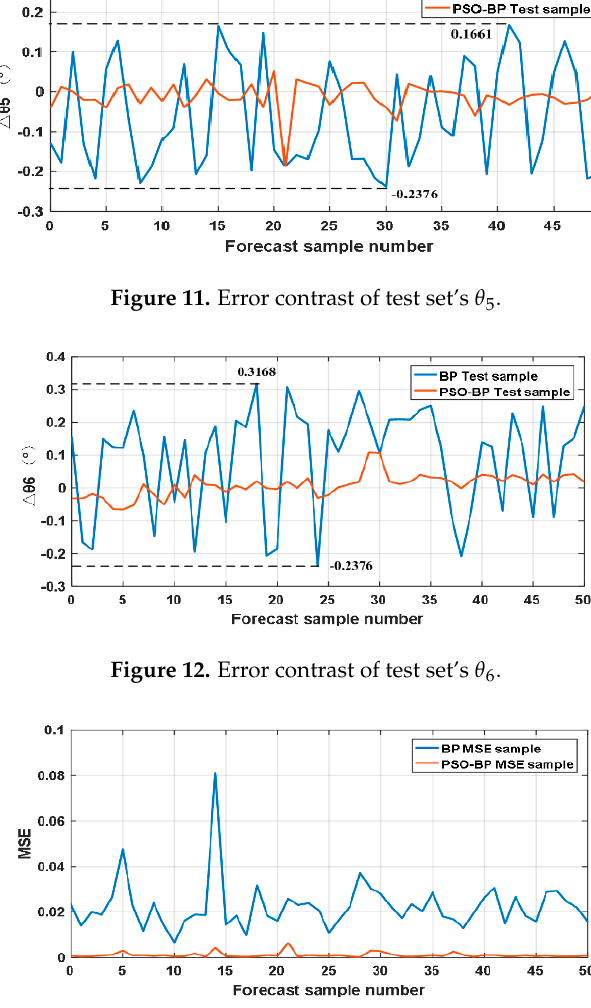
Figure 13. Mean square error (MSE) contrast of test set’s θ . Table 2. Error range test set and mean square error.